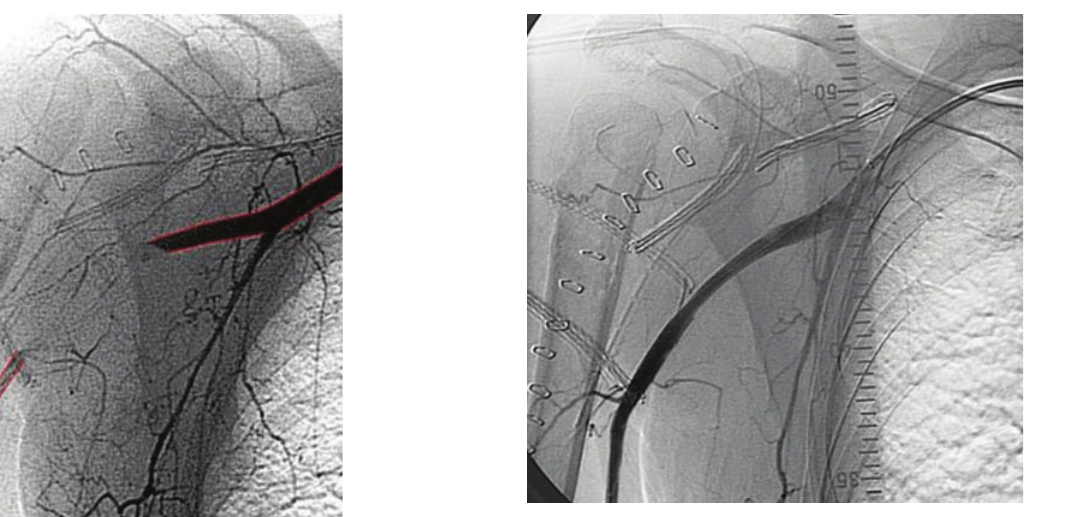
Figure 10: Restored vascularisation after stenting the axillary artery. Table 1: Clinical presentation of arterial